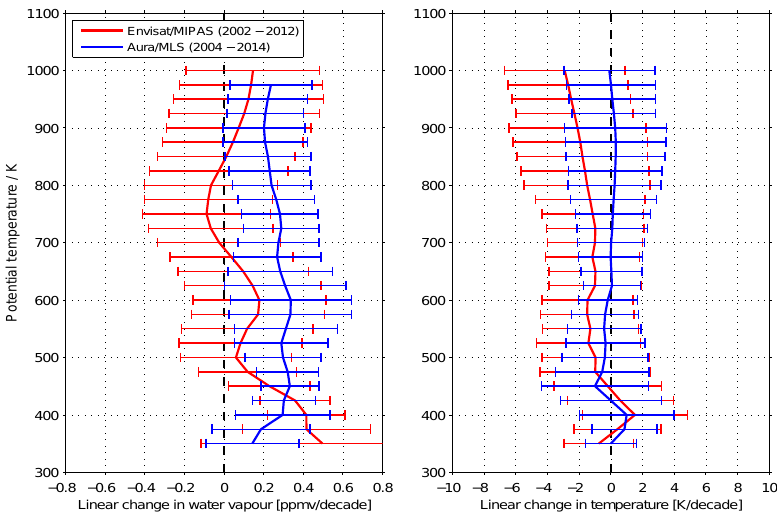
Figure 13. Linear change in water vapour (left) and temperature (right) vs. potential temperature derived from Envisat/MIPAS (2002–2012) and Aura/MLS (2004–2014). For the linear change in water vapour derived from Envisat/MIPAS an offset of 0.1ppmv between the two measurement periods has been considered. As error bars the 2 σ uncertainty is given.